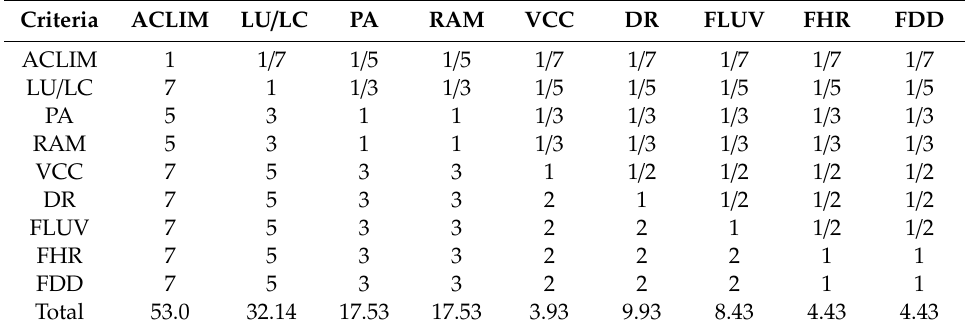
Table 11. Pairwise comparison matrix for factor criteria in the AEZ